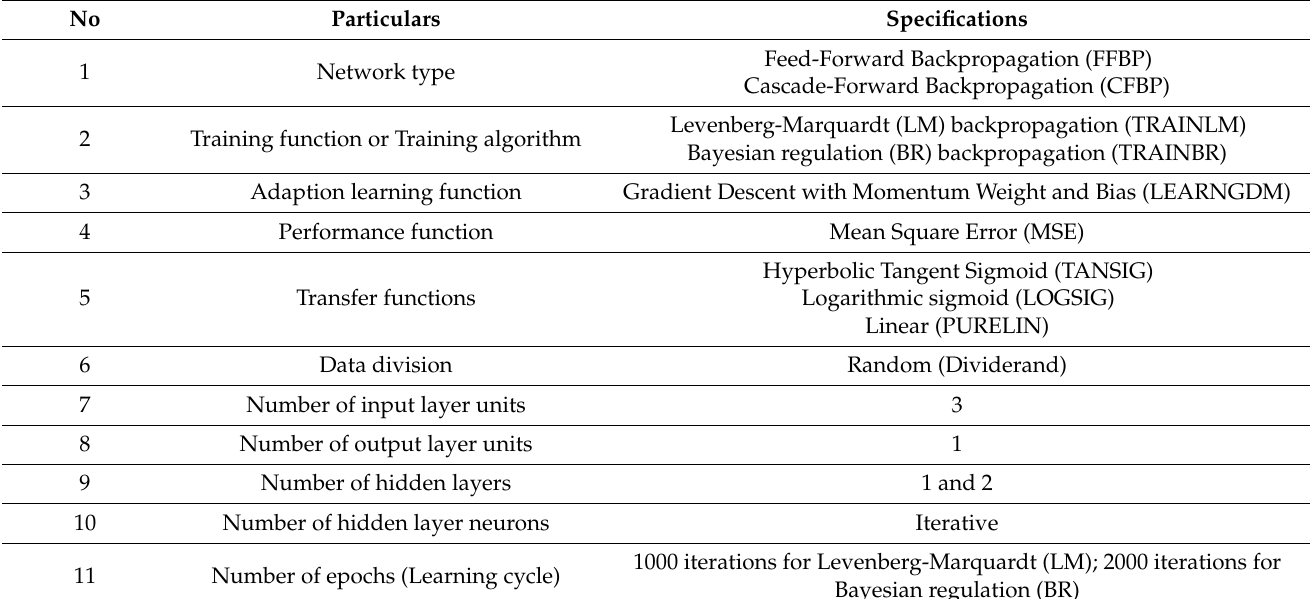
Table 2. Details of the ANN